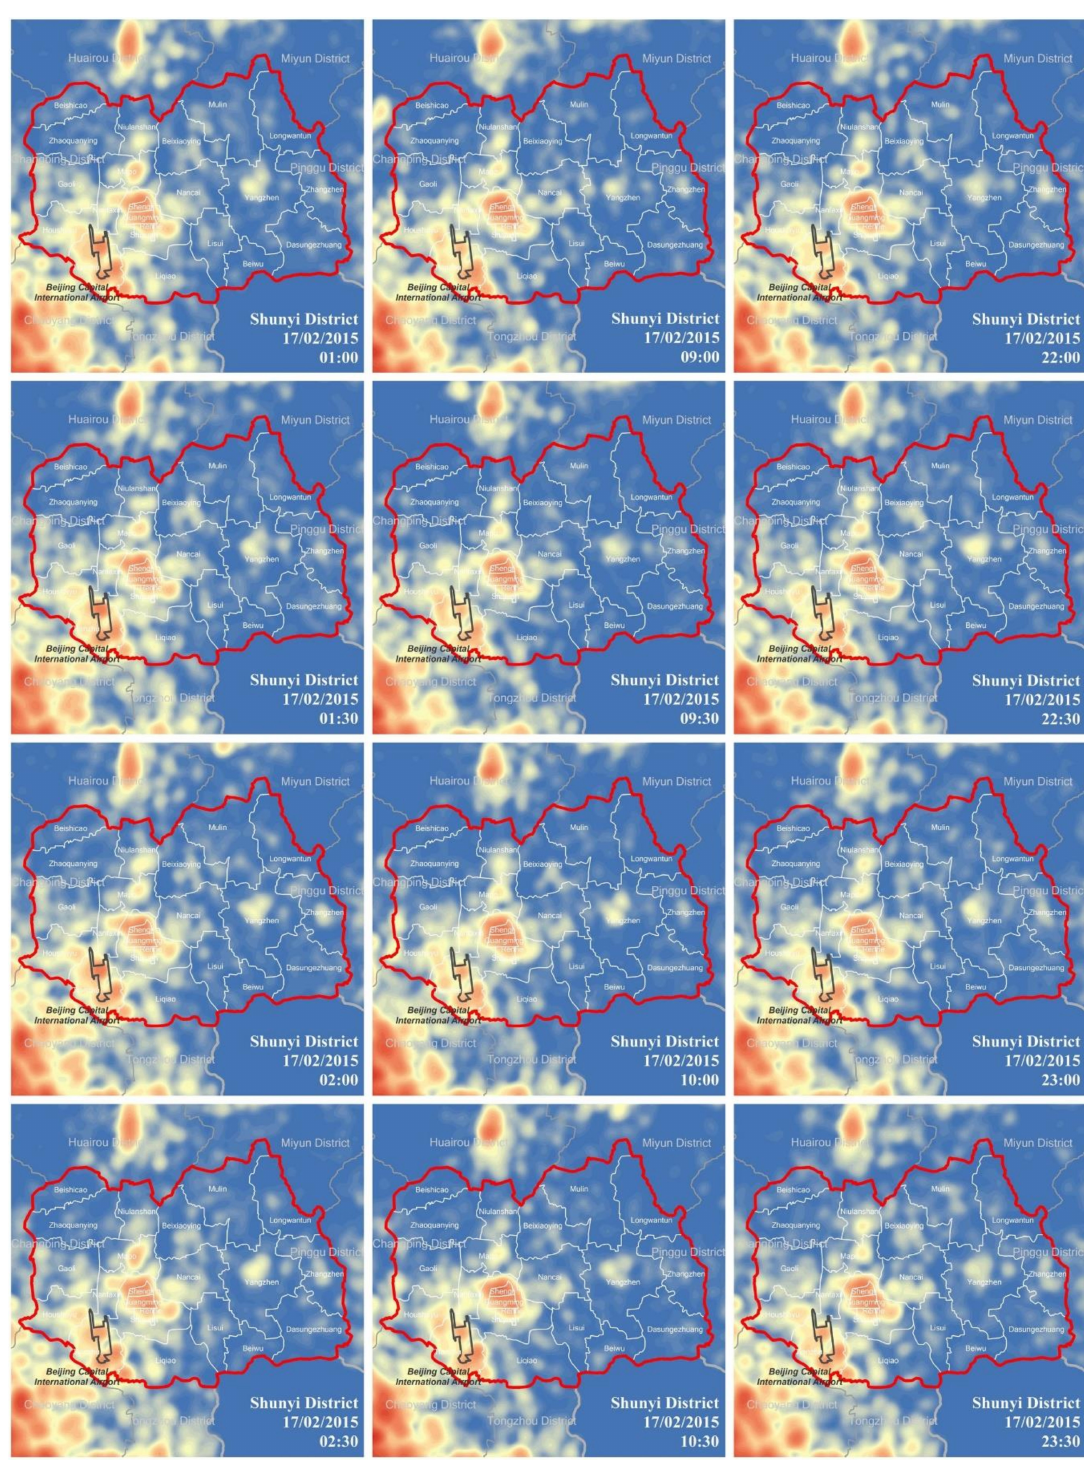
Figure 17. Estimated population density distribution on 17 / 2 / 2015 for the Shunyi District in Beijing: the 4 images in the first column are the distributions at 1:00, 1:30, 2:00 and 2:30 a.m., while the next 4 images in the second column are from 09:00 to 10:30 A.M, and the 4 images in the last column are for the end of the